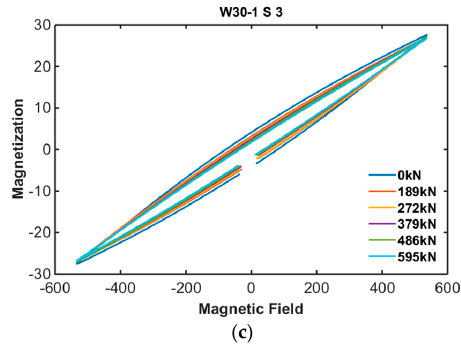
Figure 7 . B-H loop of specimen 1: ( a ) Sensor no. 1-1; ( b ) Sensor no. 1-2; ( c ) Sensor no. 1-3.